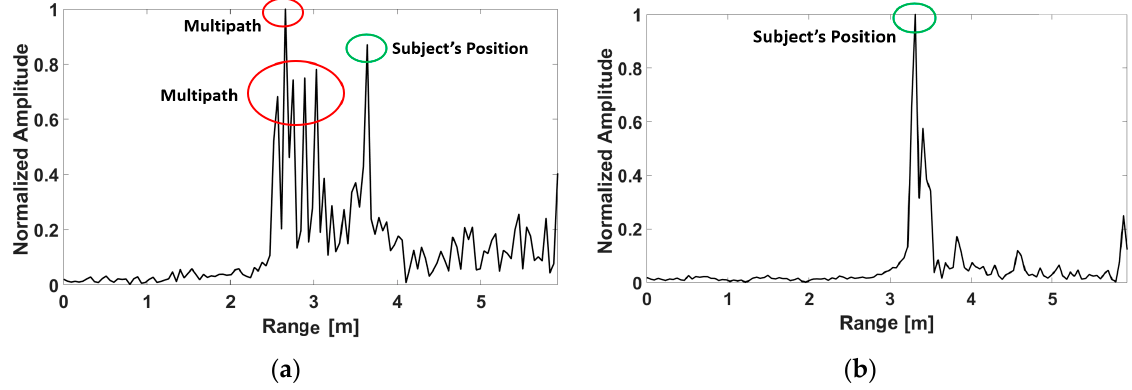
Figure 3. Range of a walking subject at frame 150 ( a ) without the lens ( b ) with the lens.